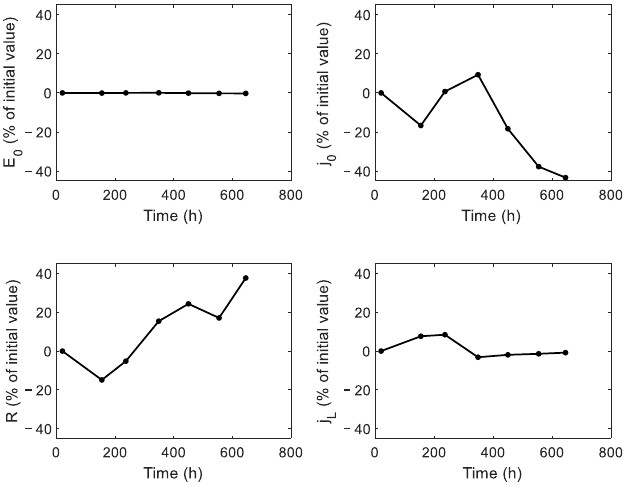
Figure 5. Evolution of the model parameters.